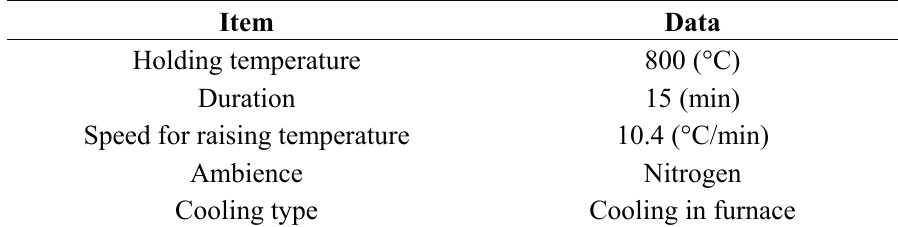
Table 3. Process parameters for ZnO films treated by furnace annealing.